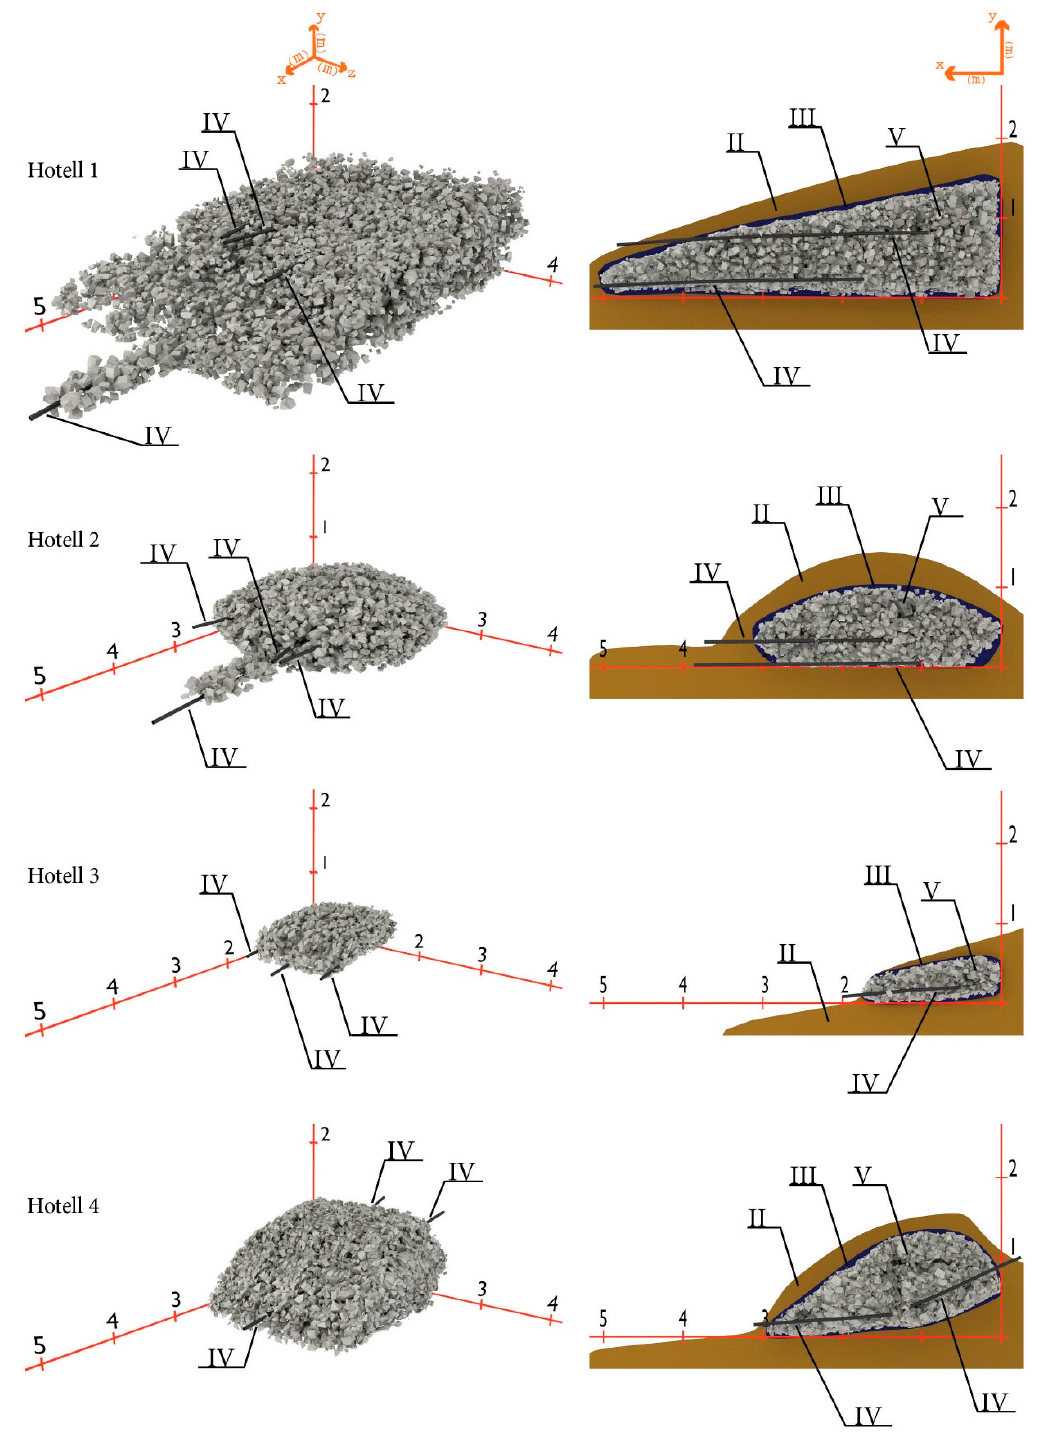
Figure 2. Sketches of the hotels. Hotel 1 = 12.4 m 3 , Hotel 2 = 4.1 m 3 , Hotel 3 = 1.7 m 3 and Hotel 4 =